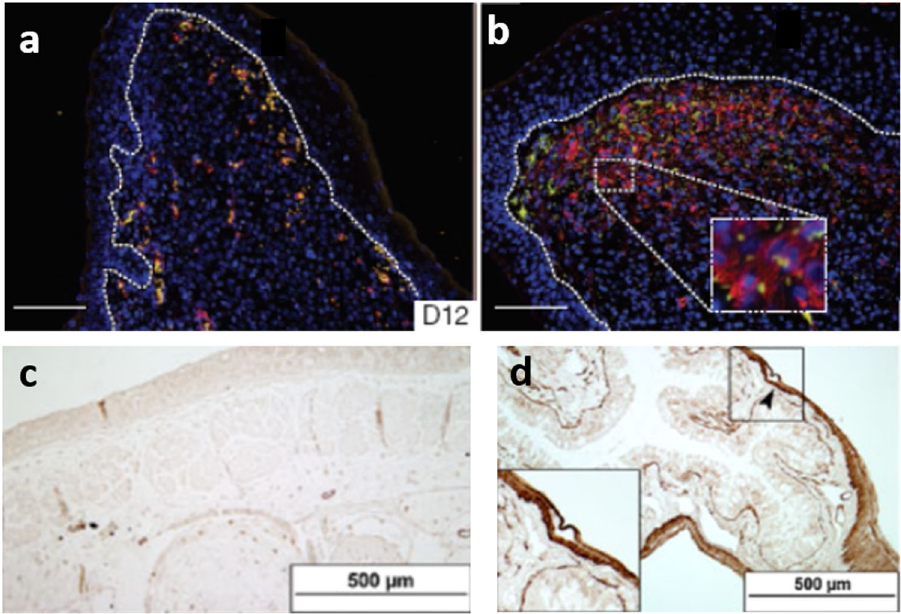
Fig. 3 The absence of wound contraction has been reported in several cases of spontaneous scarless healing in various species. a No α SMA + fi broblasts (red) were detected 12 days after full-thickness ear injury in A. kempi , which are able to spontaneously regenerate severe skin injuries. b In contrast, a signi fi cant number of α SMA + cells (red) were detected in ear injuries in Mus musculus mice, which spontaneously heal such injuries by forming a scar 35 . c , d The axolotl can regenerate spontaneously injuries in several organs, including its limbs and tail. c α SMA staining was not detected in skin injuries, 12 days after injury. d In the same animal, α SMA (brown) was detected in control tissue (small intestine) 37 – 39 . Figure 3a, b were reproduced with permission from Nature 489, 561 – 66, © Springer Nature (2012). Figure 3c, d was reproduced with permission from J. Exp. Zool. B. Mol. Dev. Evol., 314B, 684 – 97, © Wiley